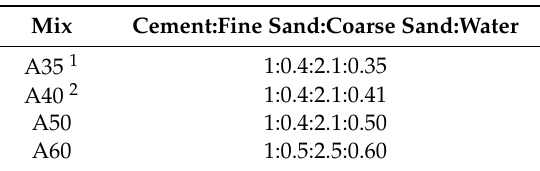
Table 1. Mix proportions (wt./wt.).